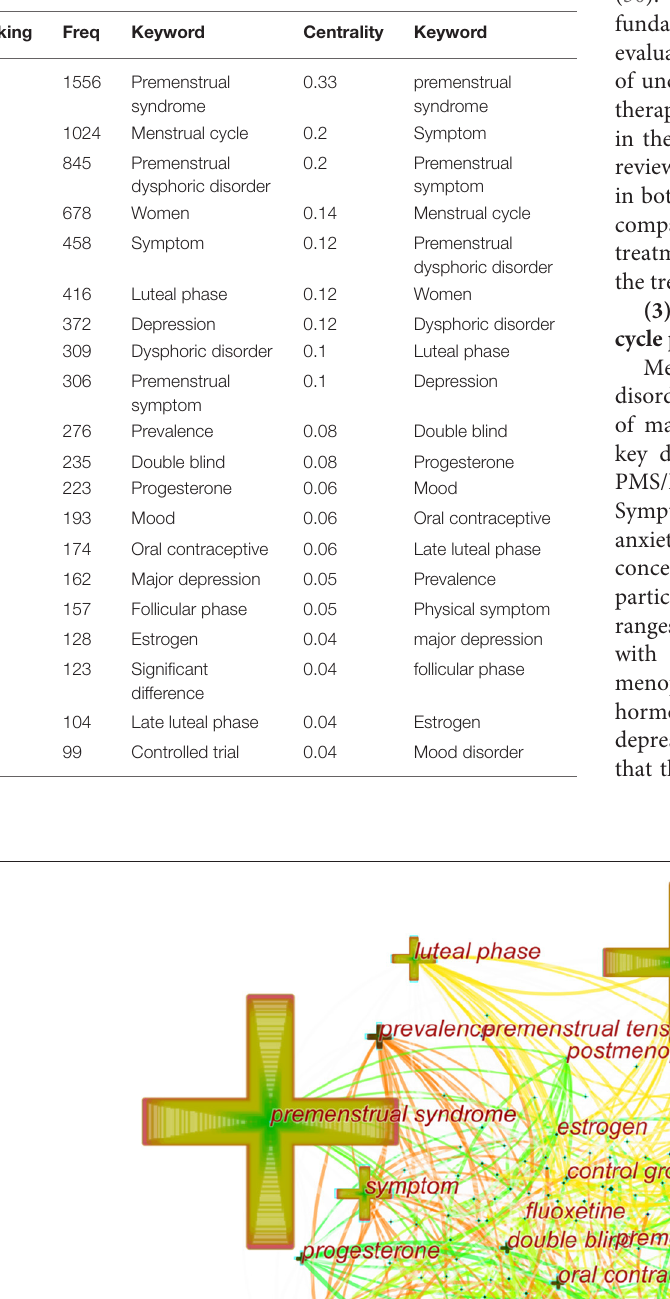
Frontiers in Public Health |